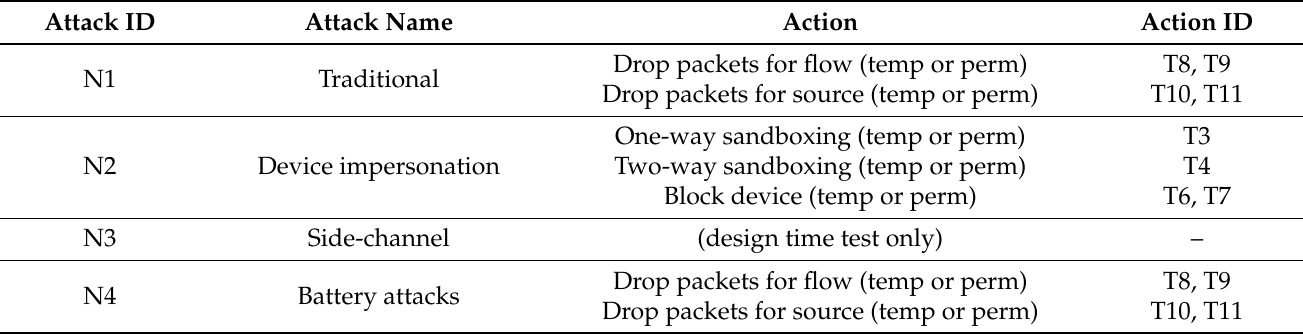
Table 5. Technical actions in network attacks.